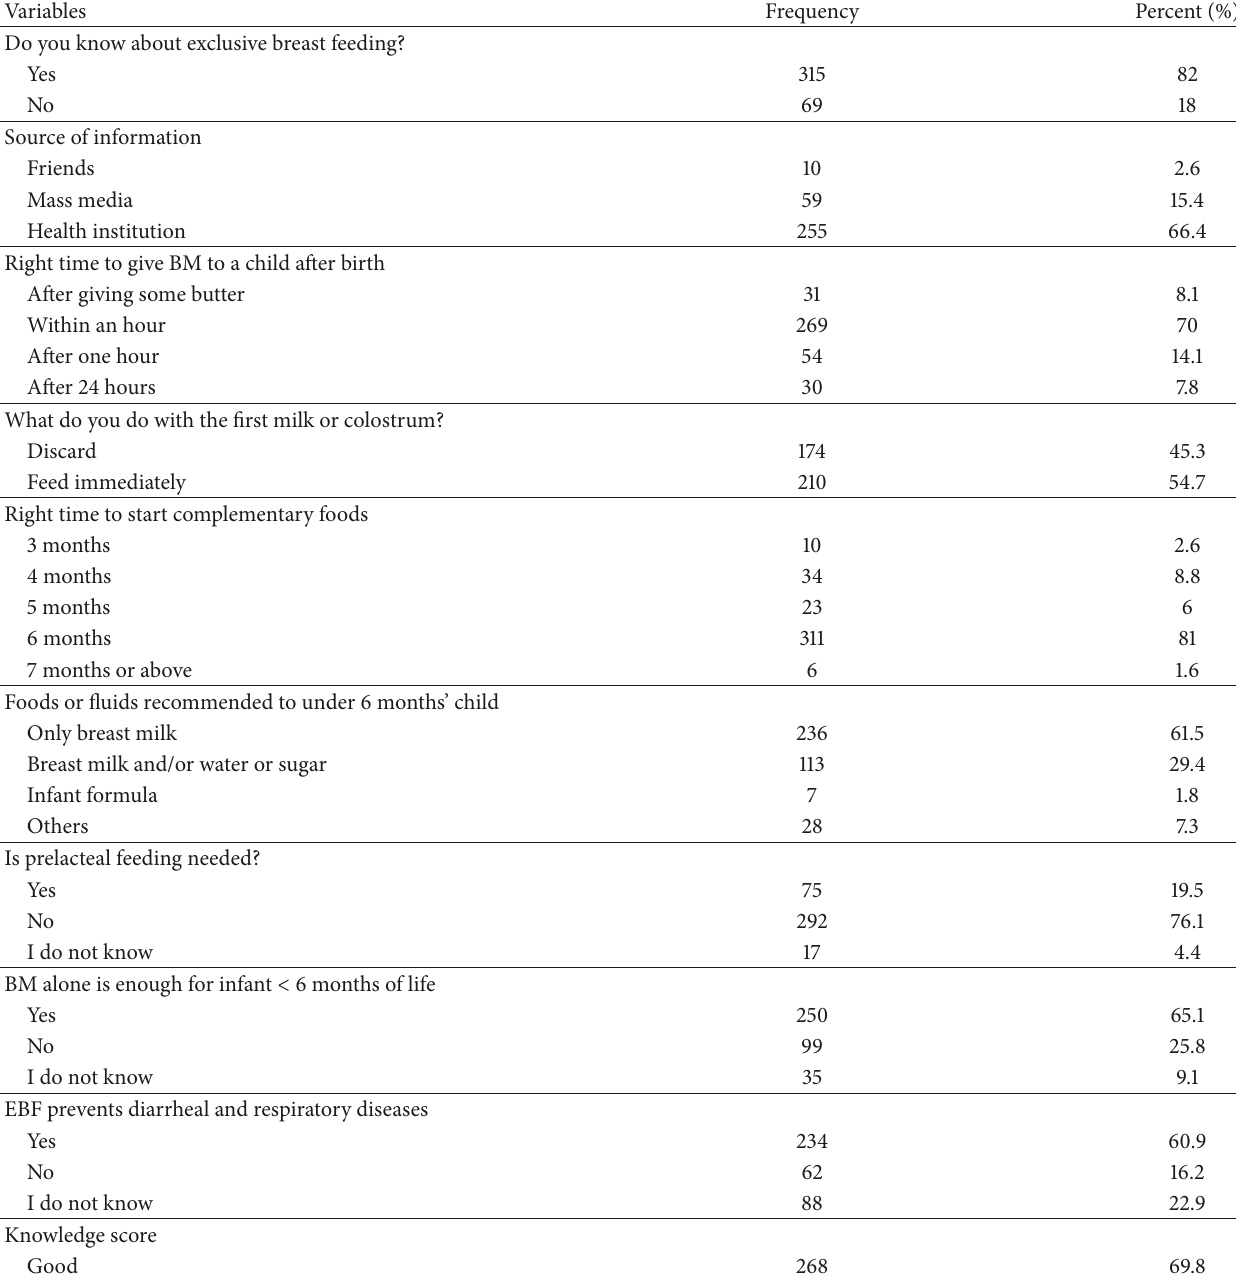
Table 2: Knowledge of study participant mothers towards exclusive breast feeding, Dabat Health Center, Northwest Ethiopia, 2016. 𝑛 = 384 .